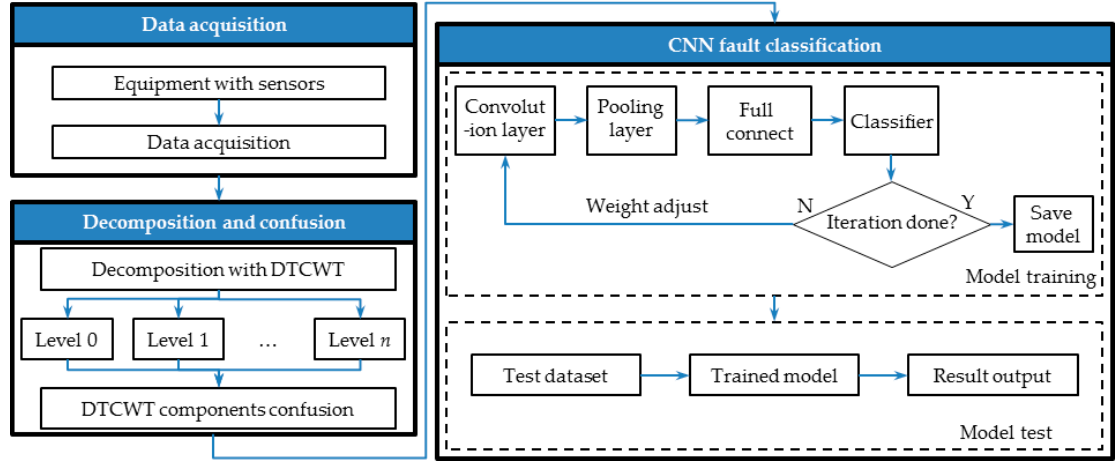
Figure 6. Flow chart of the proposed method. CNN, convolutional neural network.